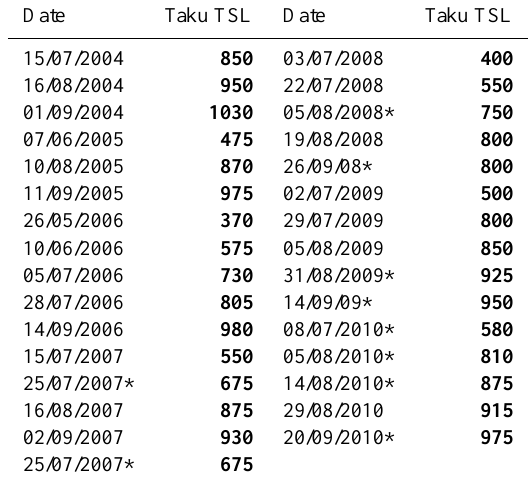
Table 1. Dates of transient snowline identification ( m ) for Taku Glacier from Landsat 4–7 imagery and MODIS imagery